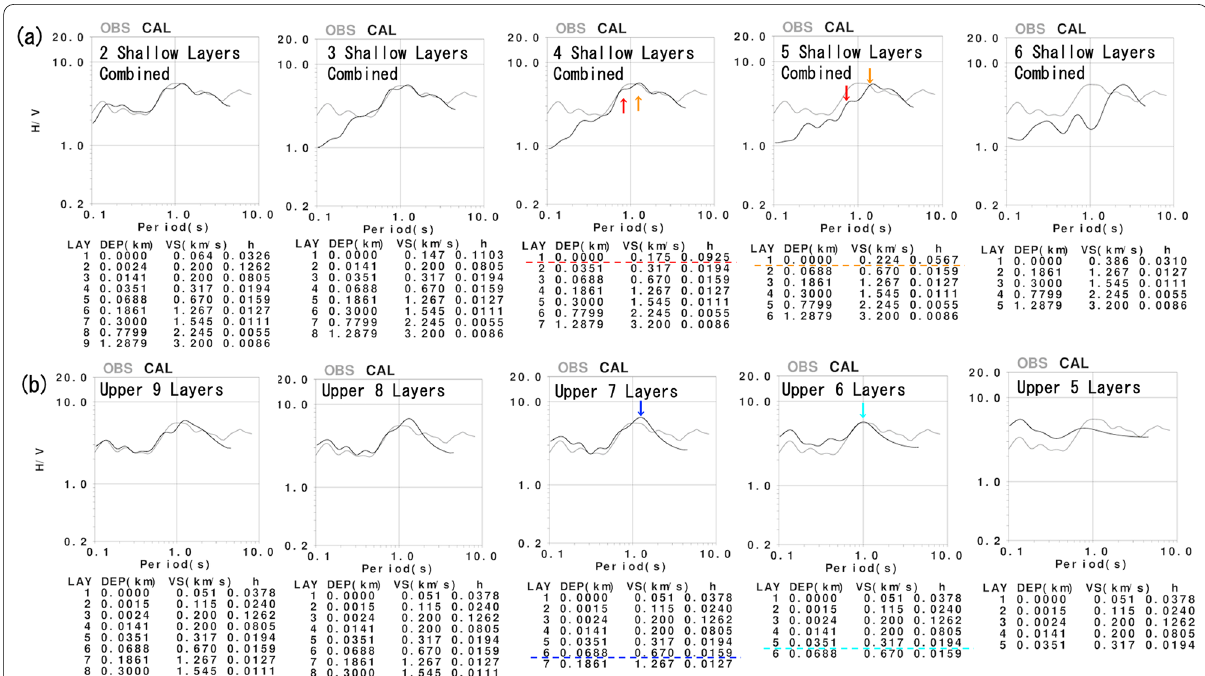
Fig. 4 a Calculated EHVSR by combining the surface layers in order from the shallow layer with evaluated average S wave velocity of target layers. Red and orange arrows and dashed lines indicate the characteristic periods and the layer boundaries that compose them. b Same as upper row but for removing the deepest layer from the previous model. Blue and sky arrows and dashed lines also indicate the characteristic periods and the layer boundaries that compose